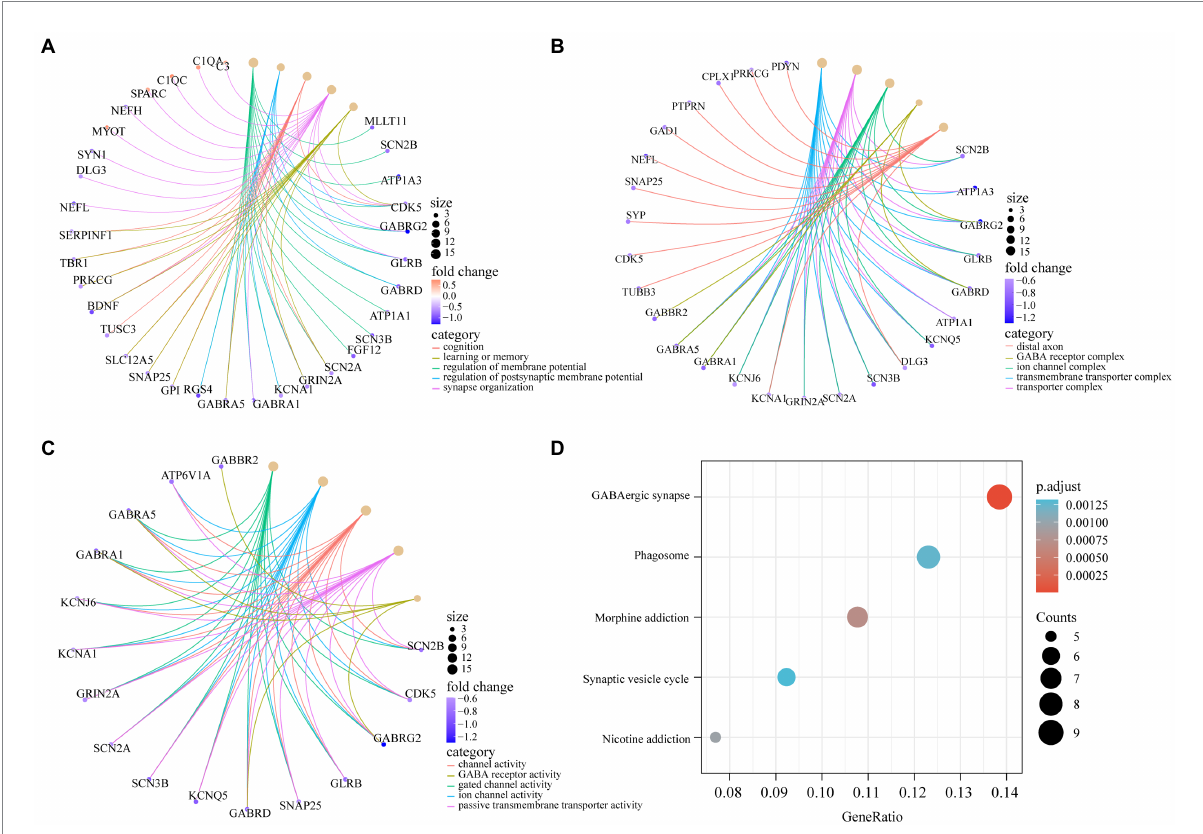
FIGURE 4 GO and KEGG pathway enrichment of AD-related DEGs. (A) The circle graph shows the AD-related DEGs enriched in the top5 GO categories of BPs. (B) The circle graph shows the AD-related DEGs enriched in the top5 GO categories of CCs. (C) The circle graph shows the AD-related DEGs enriched in the top5 GO categories of MFs. The yellow dots represent the GO categories, the color of the line delivered by a dot indicates the category of the dot in the legend, the size of a dot indicates the number of the genes included. (D) The dot plot shows the AD-related DEGs enriched in the top5 KEGG